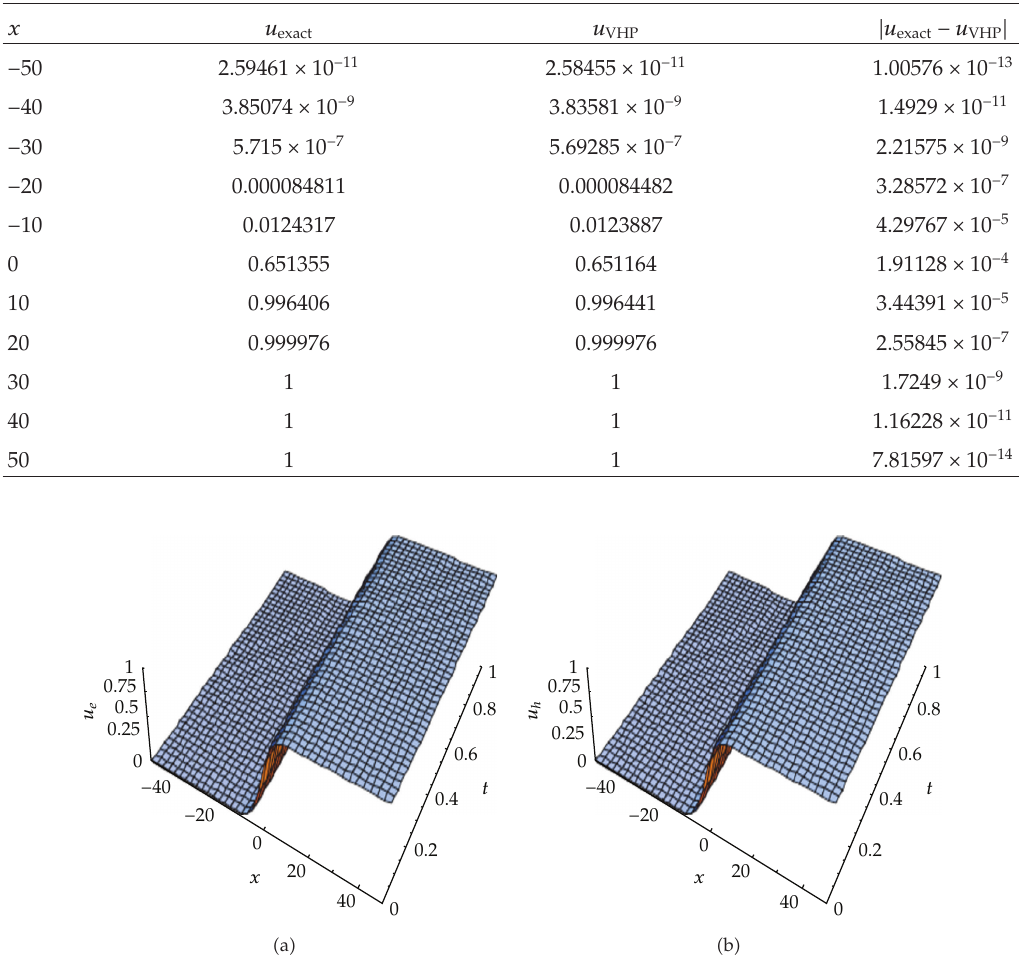
Table 1: The approximate solution (cid:2) 5.6 (cid:3) in comparison with the exact solution (cid:2) 5.2 (cid:3) if t (cid:7) 0 . 5.